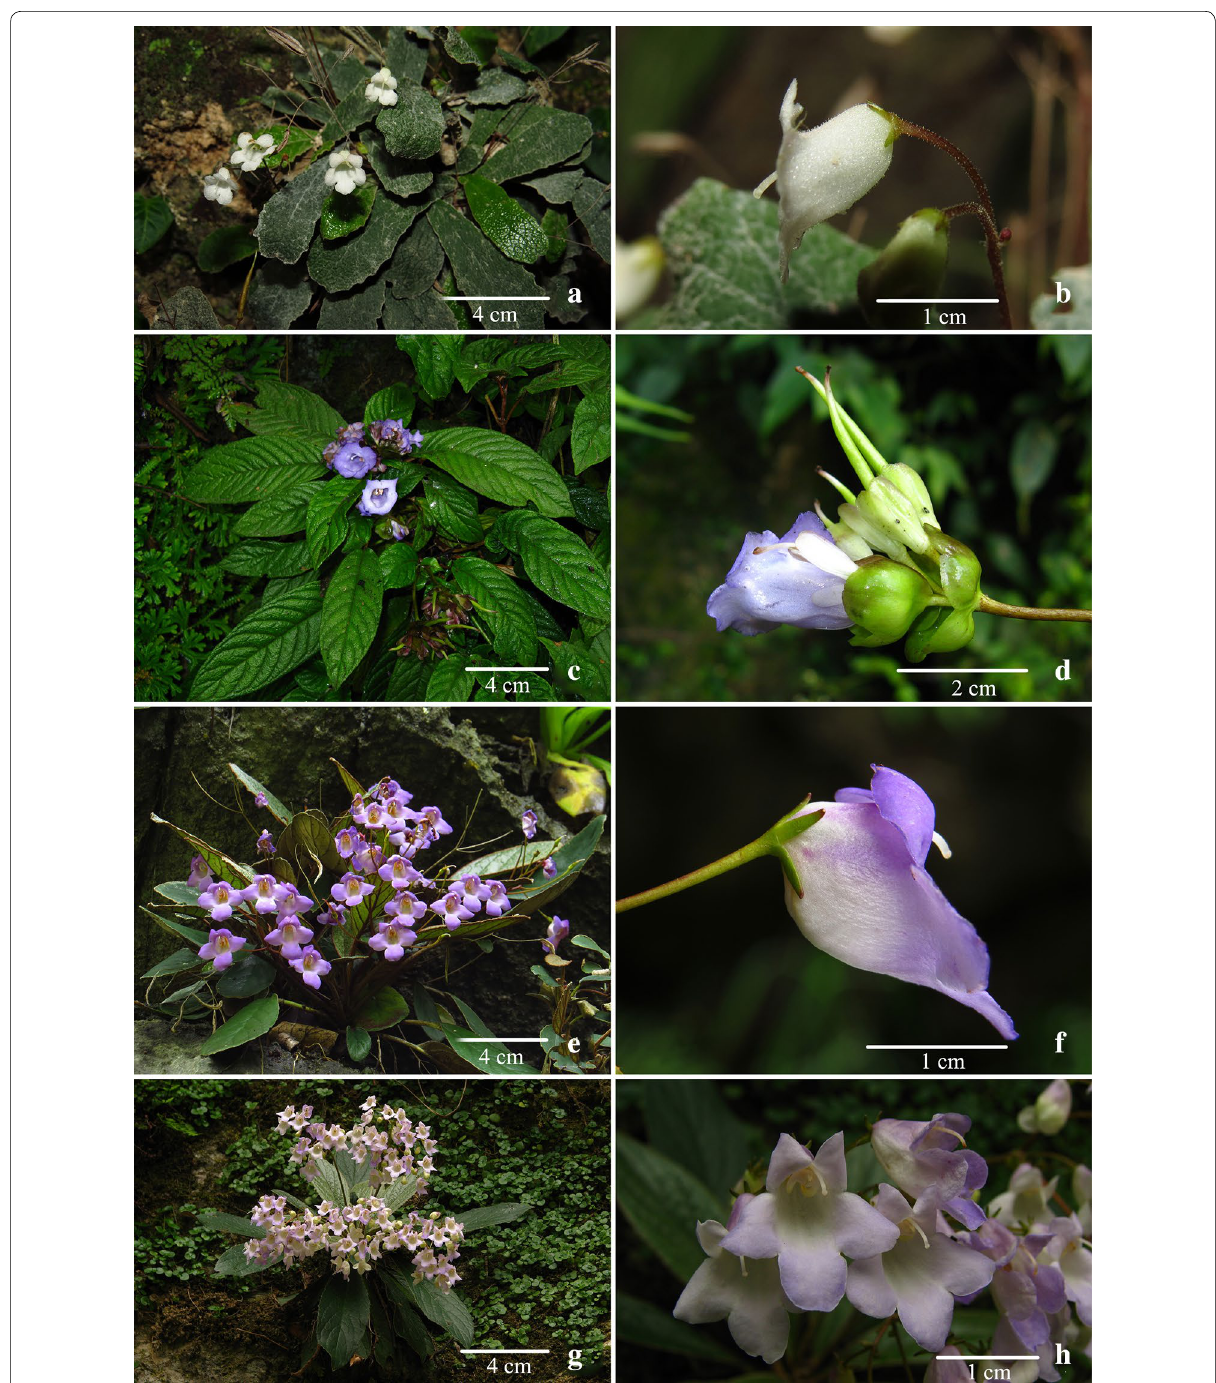
Fig. 9 Paraboea velutina (W.T.Wang & C.Z.Gao) B.L.Burtt. a Habit; b flower side view. Paraboea sinensis (Oliv.) B.L.Burtt. c Habit; d flower side view. Paraboea guilinensis L.Xu & Y.G.Wei. e Habit; f flower side view. Paraboea dictyoneura (Hance) B.L.Burtt. g Habit; h flowers face and side